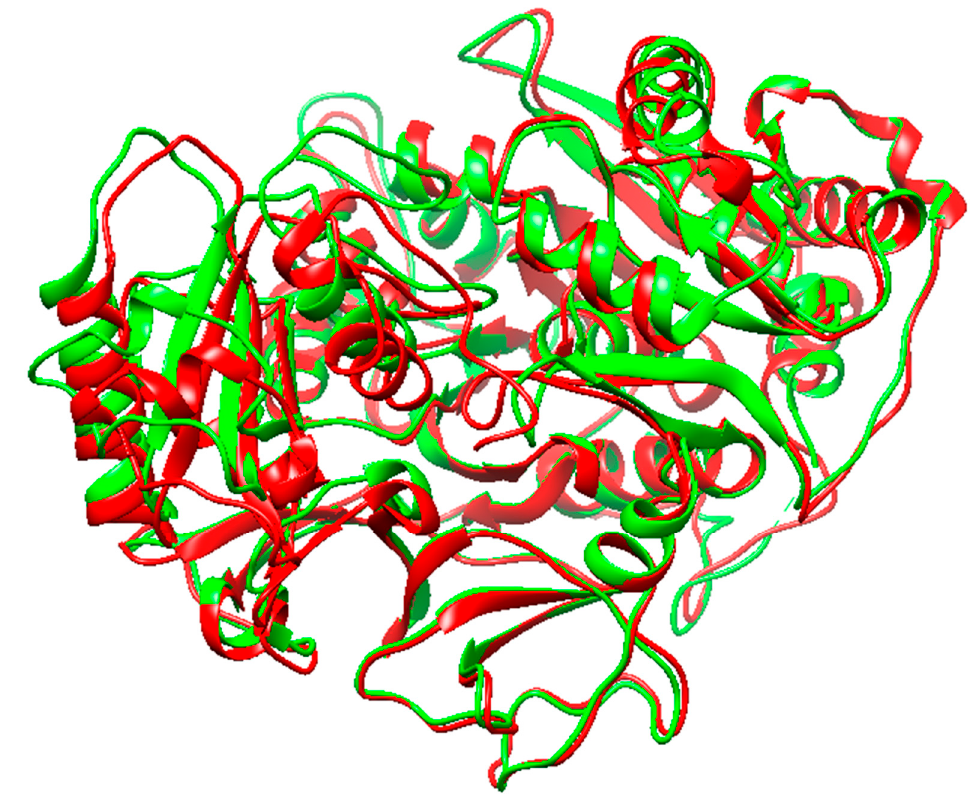
Figure 10. Aligned structures of Mtb FadD32 (green) and Msm FadD32 (red) proteins.